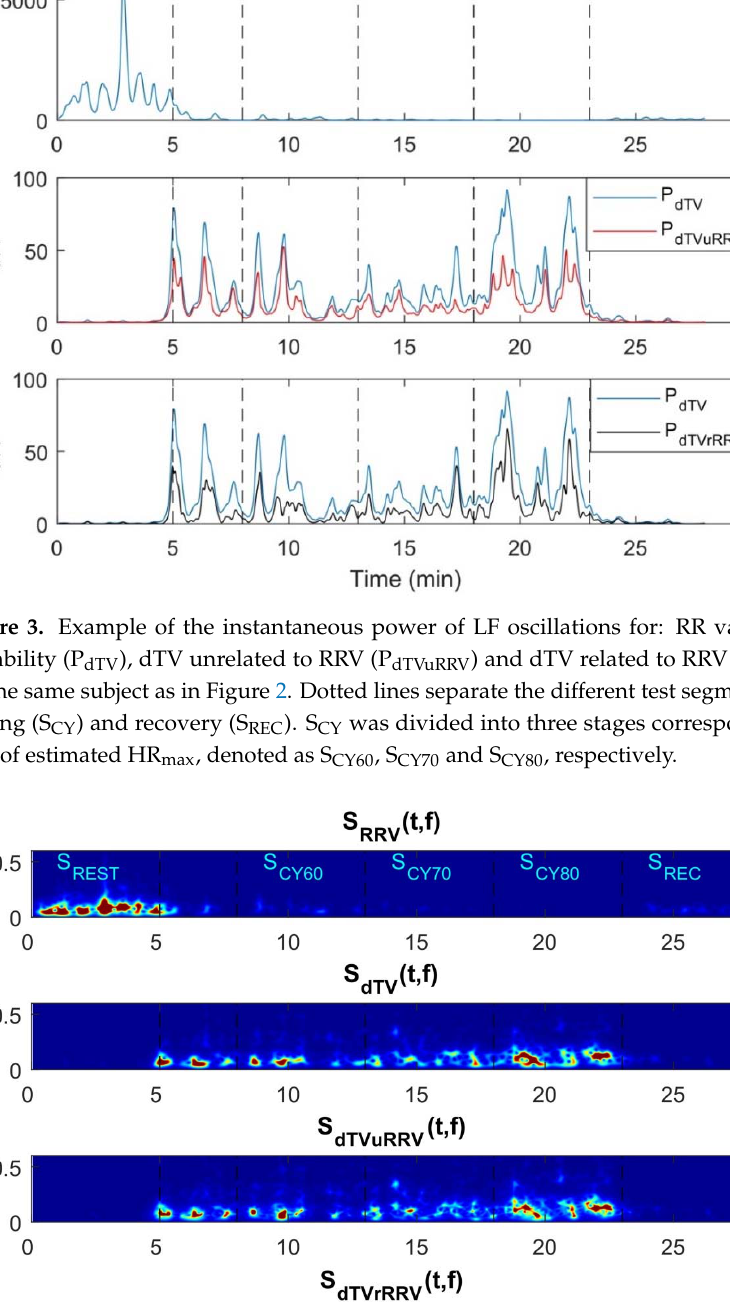
Figure 2. Example of the dT angle and RR interval time series for one subject throughout the entire test. Dotted lines separate the different test segments: resting (S REST ), cycling (S CY ) and recovery (S REC ). S CY was divided into three stages corresponding to 60, 70 and 80% of estimated HR max , de ‐ noted as S CY60 , S CY70 and S CY80 , respectively.